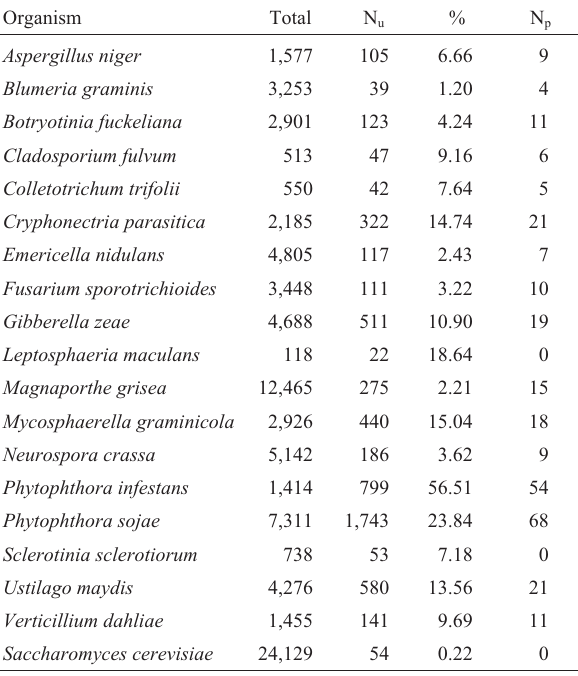
Table 1 - Comparison of P. parasitica clusters with COGEME